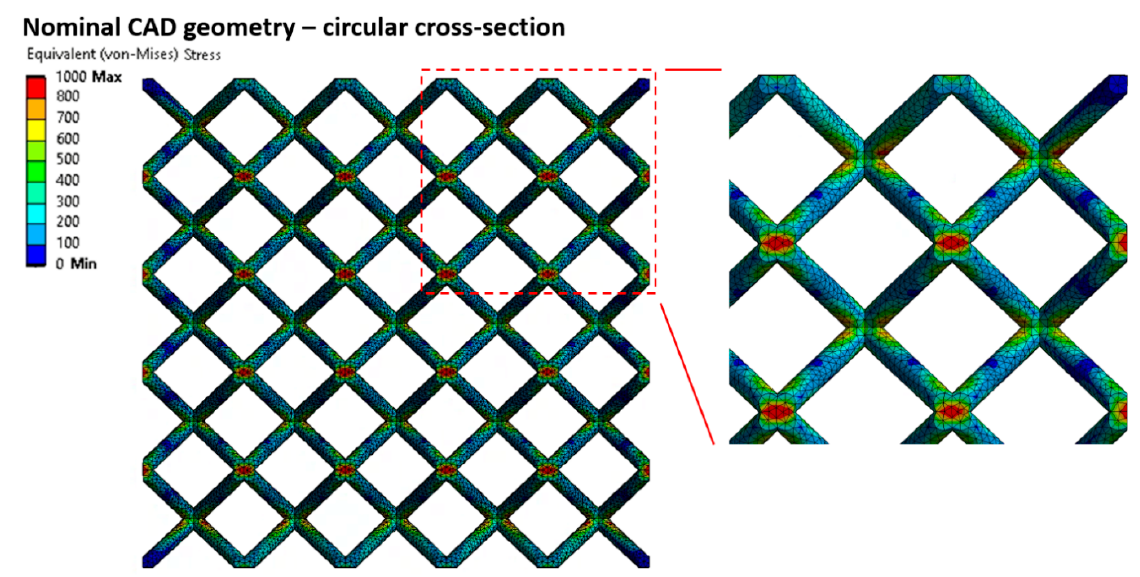
Figure 15. Equivalent (von Mises) stress distribution for a structure considering linear elastic material behavior—Circular cross-section (2.5% structure deflection).